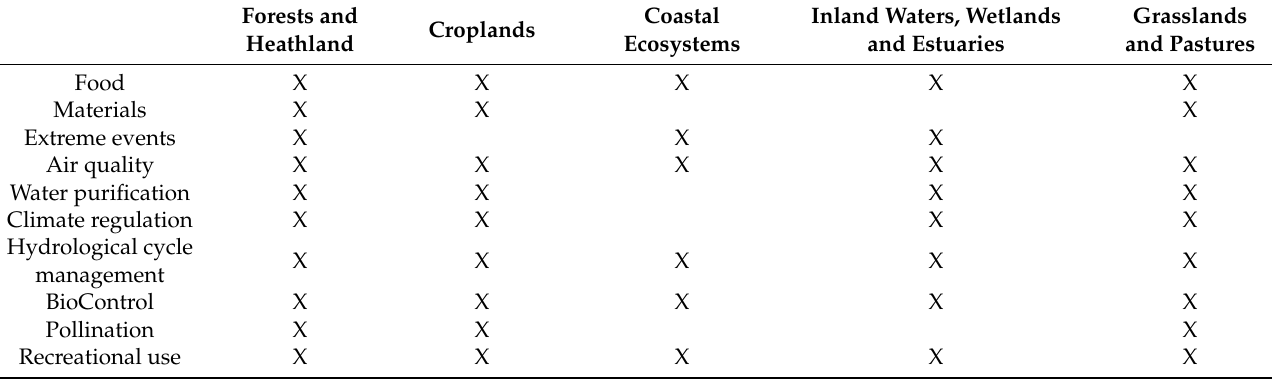
Table 1. Ecosystems present in the study area and its associated ecosystem services (based on [43]). Forests